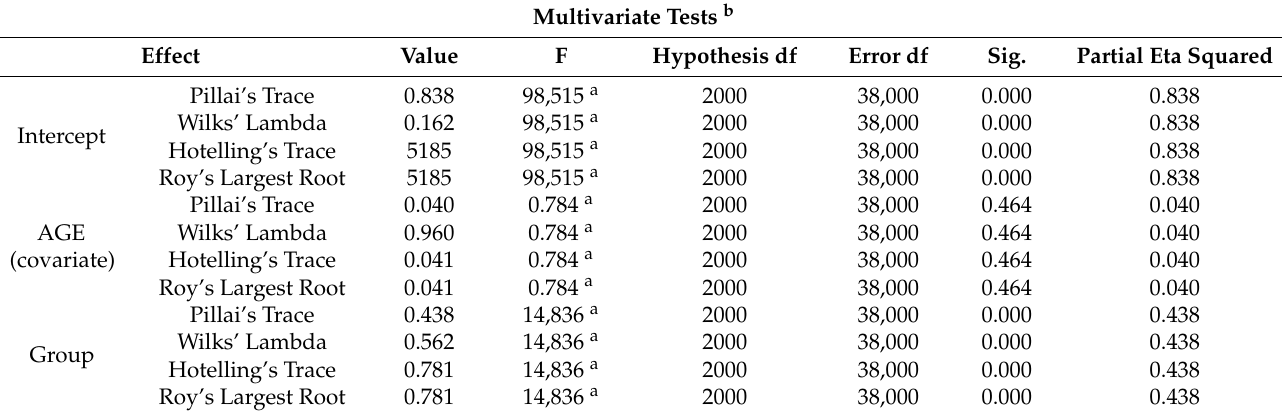
Table 3. MANOVA comparing CC VD whole and fovea between healthy and ae-AMD showed statistical significance. No significant effect of age as a covariate factor was found.